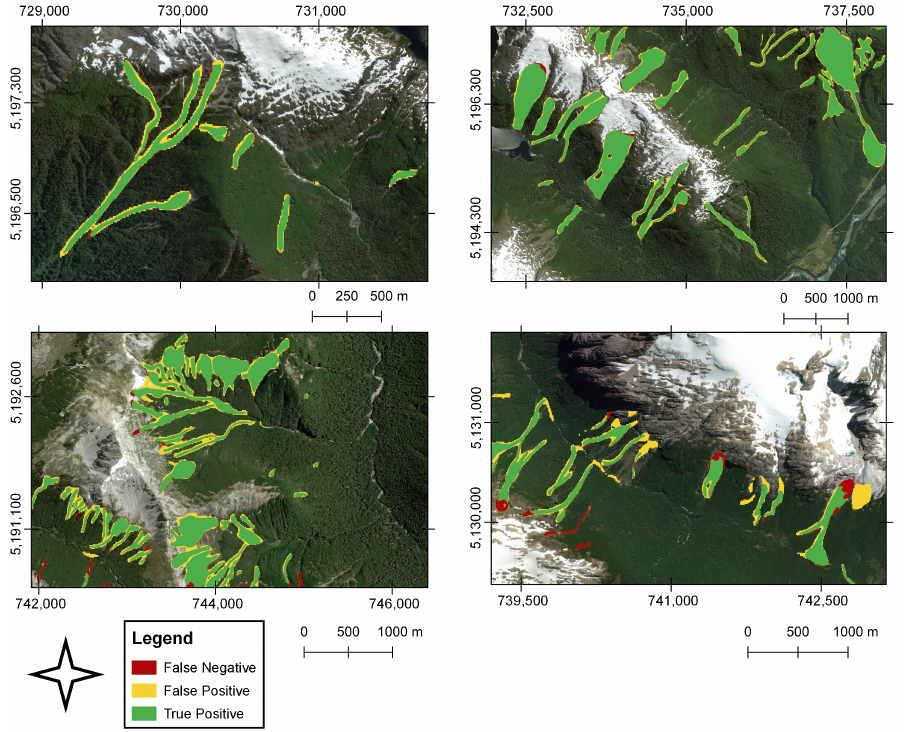
Figure 4. Landslide mapping using the trained model in a test area in Patagonian Andes. The best model results are